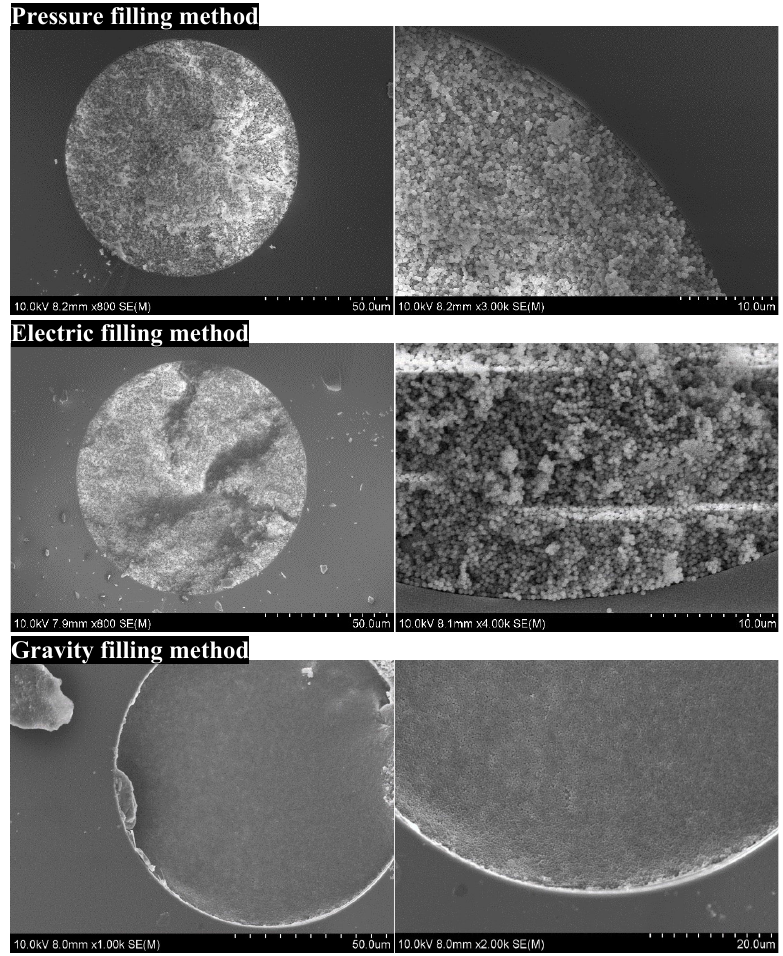
Figure 3. Cross sections of the capillary columns obtained by the pressure filling, electric filling, and gravity sedimentation self ‐ assembly methods, respectively.